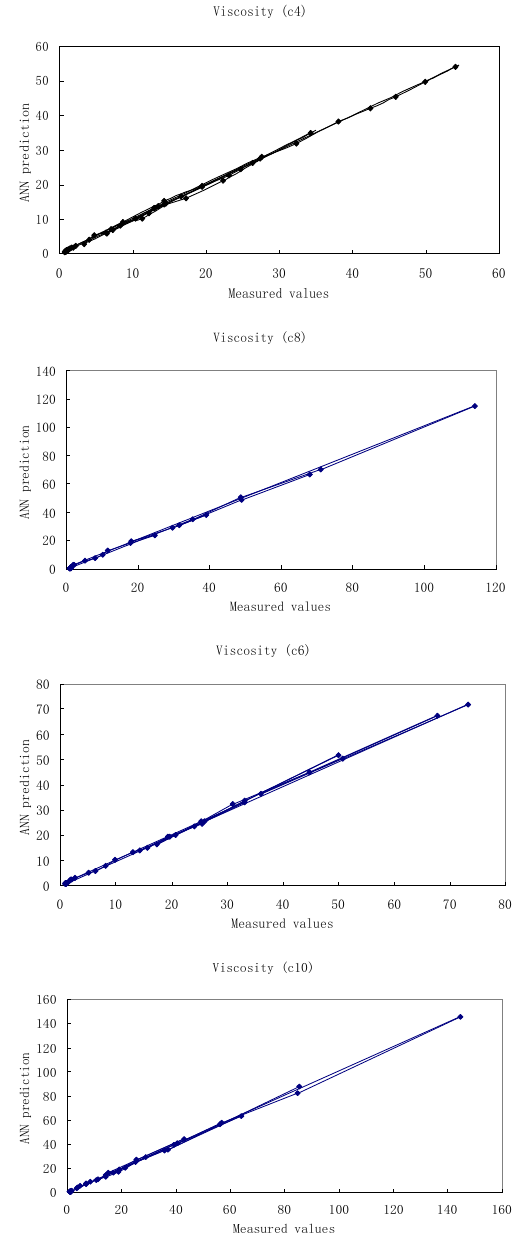
Fig. 5.4 A scatter plot as an evaluation of ANN performance for [C n -mim][NTf 2 ]-ethanol mixture with n =4, 6, 8, 10. Liquid viscosity strongly depends on temperature due to changes in thermal/kinetic energy at molecular level and changing activation energy of viscous flow. Temperature change may also significantly alter the nature of molecular interactions in binary mixtures, thereby increasing or decreasing the effect of molecular interactions on compositional viscosity. At